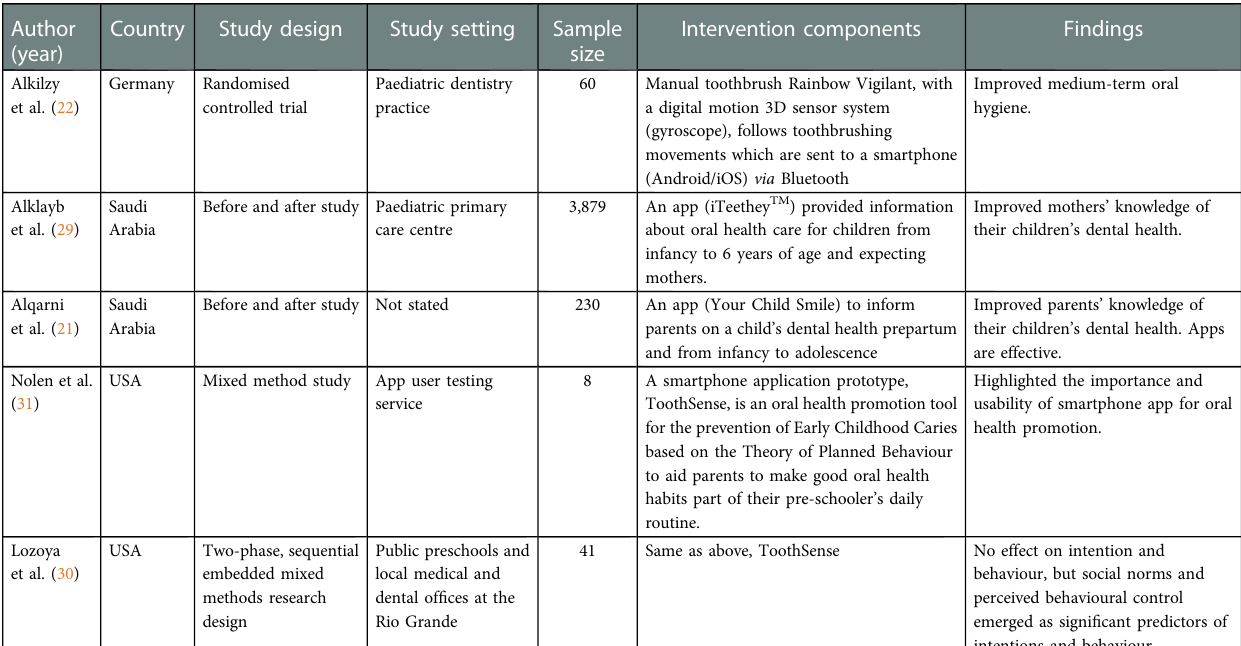
TABLE 1 Summary of included fi ve